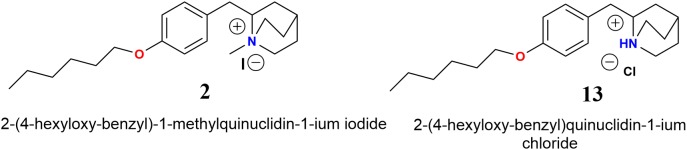
Molecular structures of N-methylquinolidinium iodides 2 and quinuclidinium chloride 13 (Arias et al., 2013).